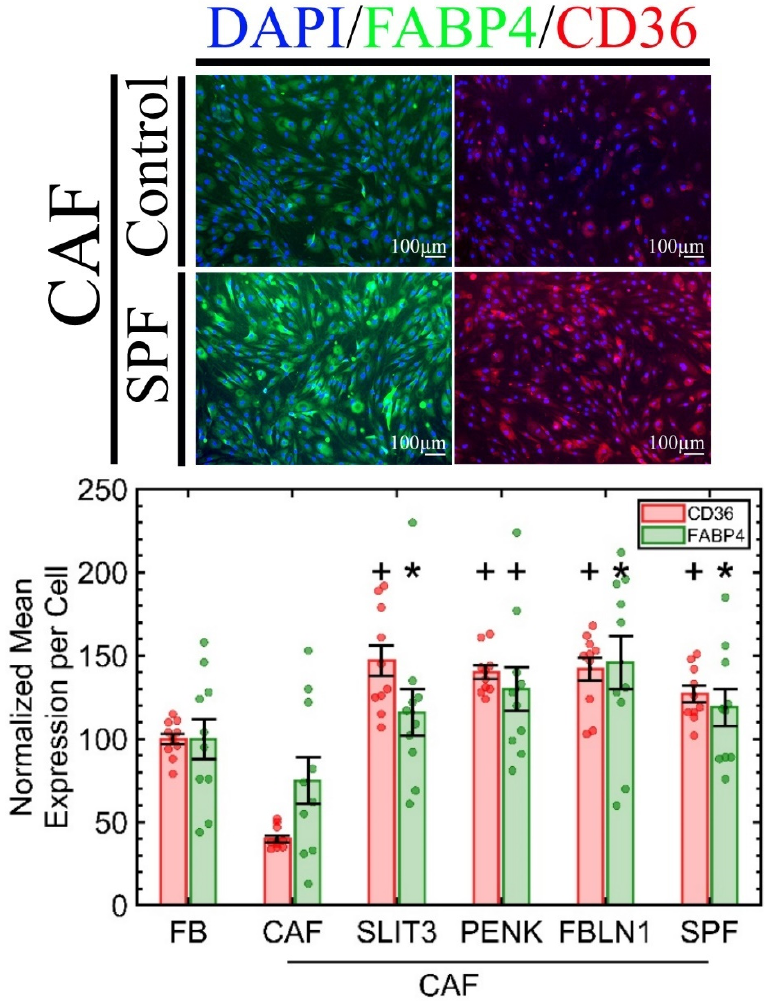
Figure 3. A CAF primary cell is reprogrammed by overexpressing CD36 and FABP4 when incubated with each of the recombinant proteins. The cocktail of RPs did not have a significant additive effect. Each condition had six replicates with at least two fields of view per well imaged. * p -value < 0.05 and + p -value < 0.001.